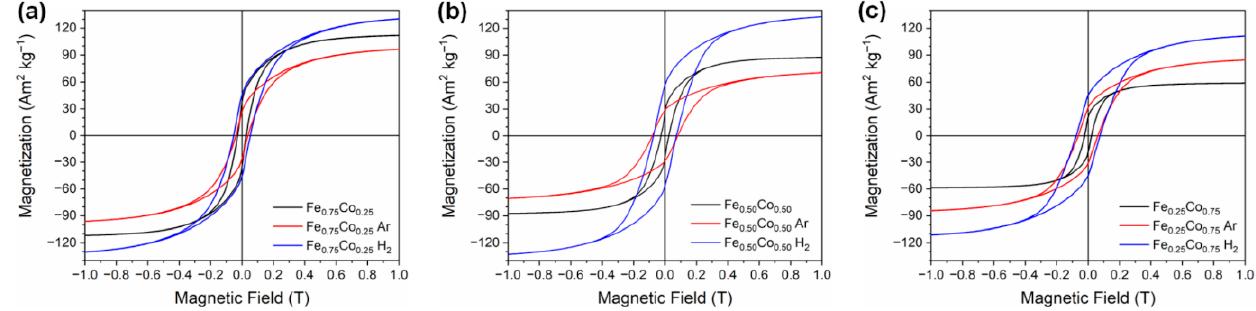
Figure 6. Room temperature magnetic hysteresis loops of as-prepared and annealed ( a ) Fe 0.75 Co 0.25, ( b ) Fe 0.50 Co 0.50 , and ( c ) Fe 0.25 Co 0.75 Wire-like nanochains. Table 4. Coercivity ( H C ) and saturation magnetization ( M S ) of as-prepared and annealed Fe-Co nanochains determined during the room temperature magnetic measurements.